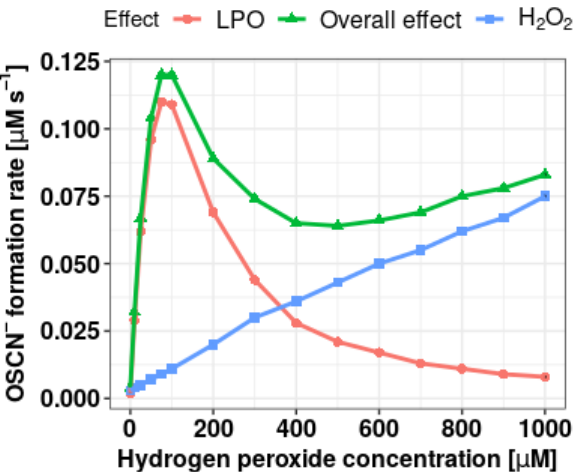
Figure 1. Relationship between the initial rate of OSCN – formation and the concentration of hydrogen peroxide. The green triangles indicate the OSCN – formation initial reaction rate, derived from the DTNB oxidation in the presence of just hydrogen peroxide (without the presence of LPO). The blue squares indicate the sum of the H 2 O 2 effect and the enzymatic reaction. The enzyme activity-related reaction rate was calculated by subtracting the H 2 O 2 -dependent rate from the sum rate value and was marked with a red circle. 3.2. Effect of Individual Extracts and Polyphenols on the Formation of OSCN – in the